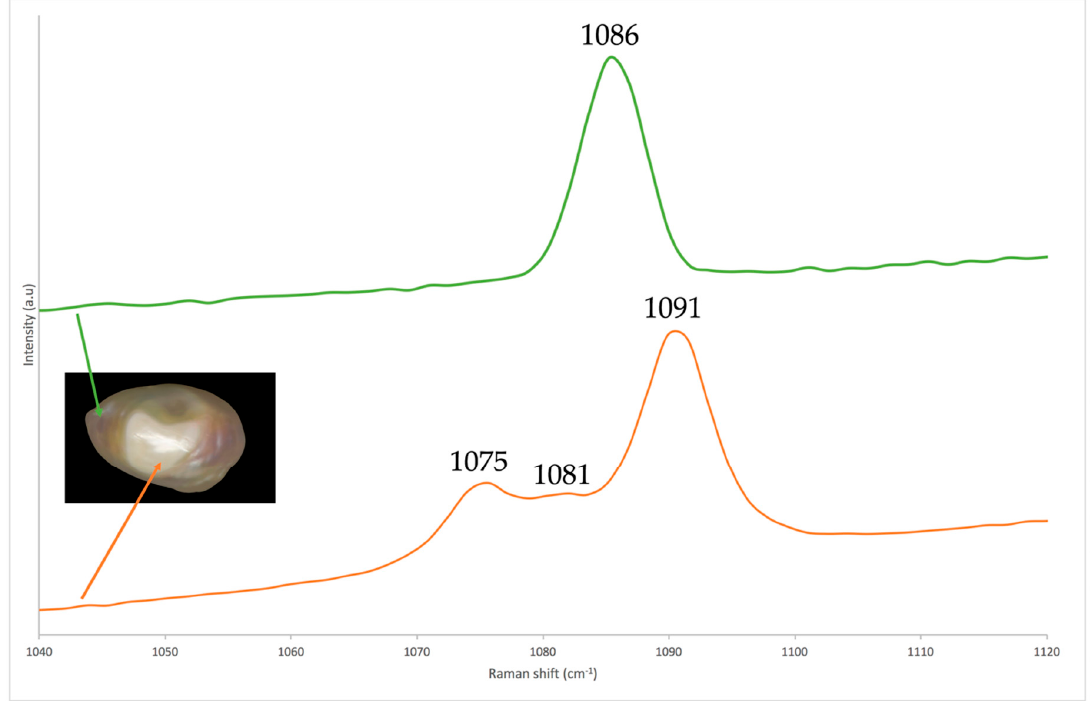
Figure 11. Raman spectra on the white part with low lustre (bottom spectrum) and on the cream coloured part with medium lustre (top spectrum) showing respectively bands due to vaterite and calcite. Note that the spectra are stacked and shifted for clarity.